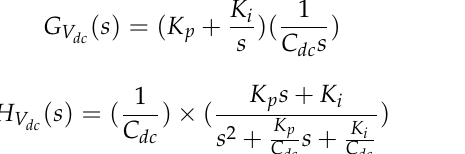
( s ) is a second-order transfer function. From the above Equation (21) indicates that H V dc closed-loop transfer function, the damping ratio ( ξ ) and bandwidth ( ω c ) are computed (𝑠) is a second-order transfer function. From the Equation (21) indicates that 𝐻 𝑉 𝑑𝑐 as follows. above closed-loop transfer function, the damping ratio ( 𝜉 ) and bandwidth ( 𝜔 𝑐 ) are computed as follows.